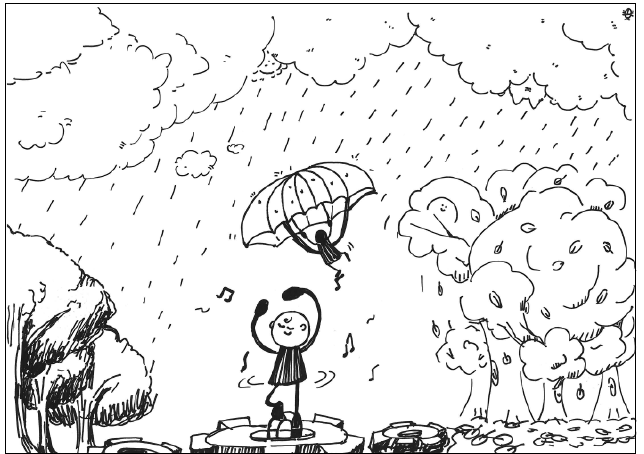
Figure 5. Work by PT5